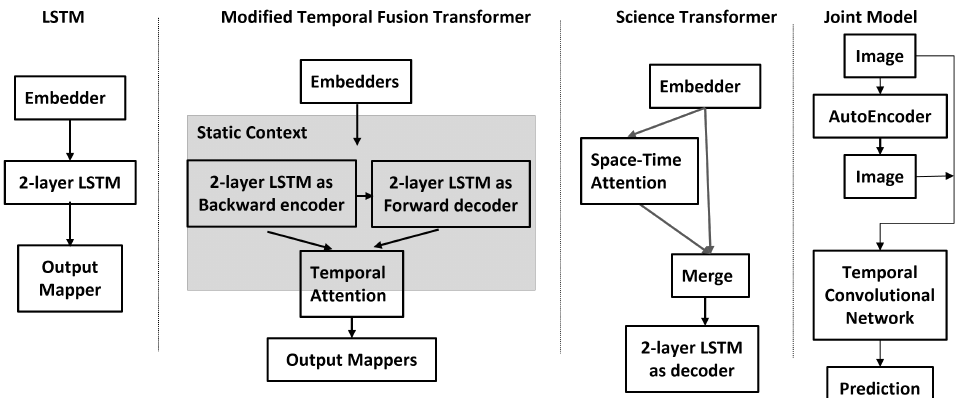
Figure 10. High-level architectures of four deep learning networks.